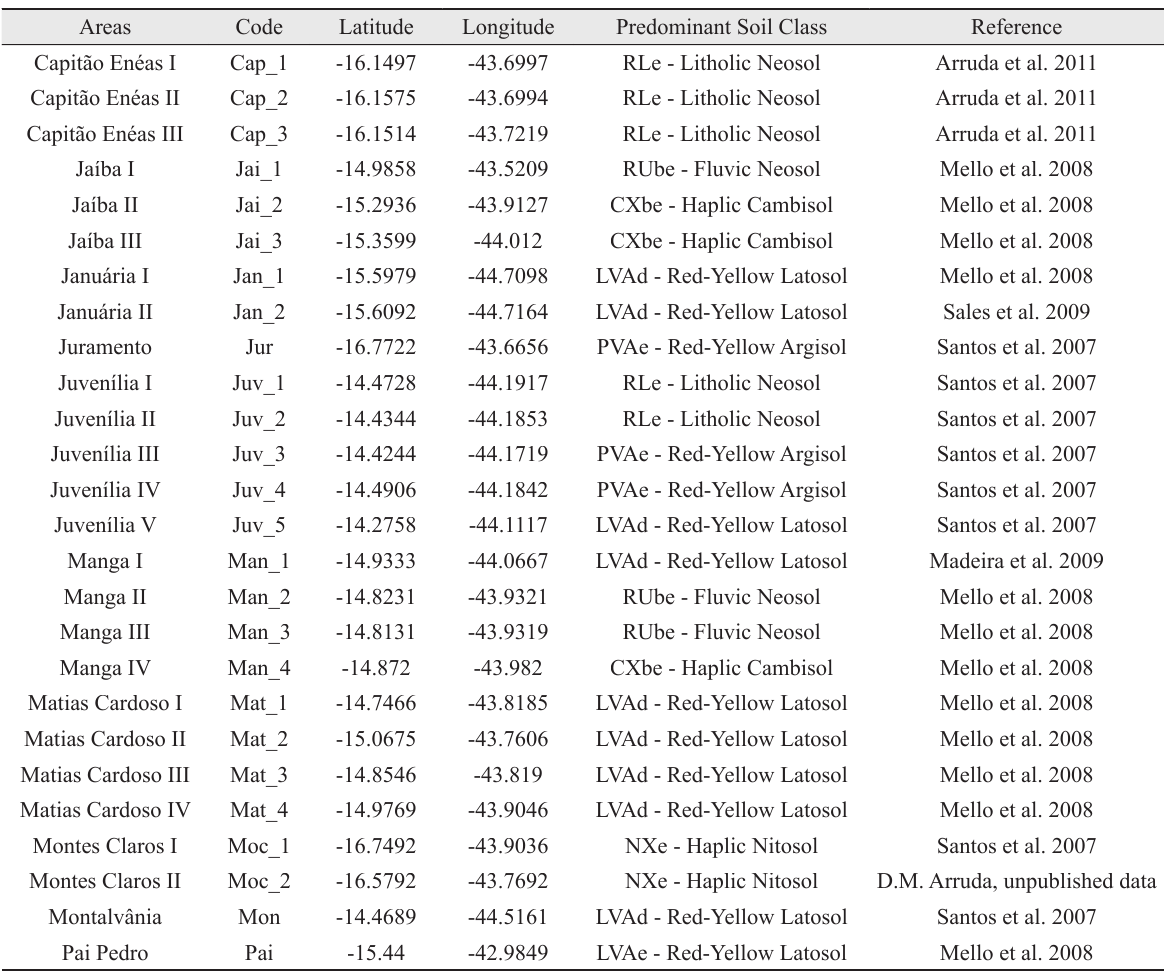
Identifi cation, geographical localization, and predominant soil class of the forest associations of